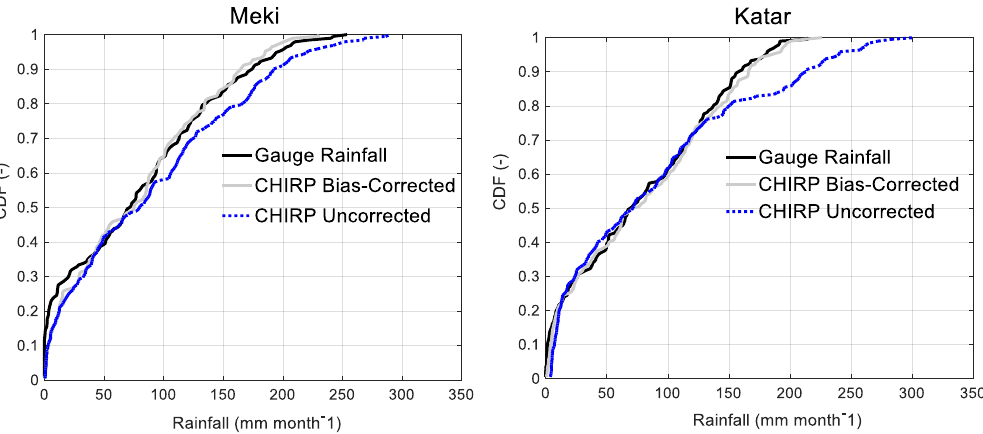
Figure 6. Cumulative distribution function (CDF) of monthly rainfall time series of gauge, CHIRP uncorrected, and bias-corrected estimate for Meki and Katar catchments.